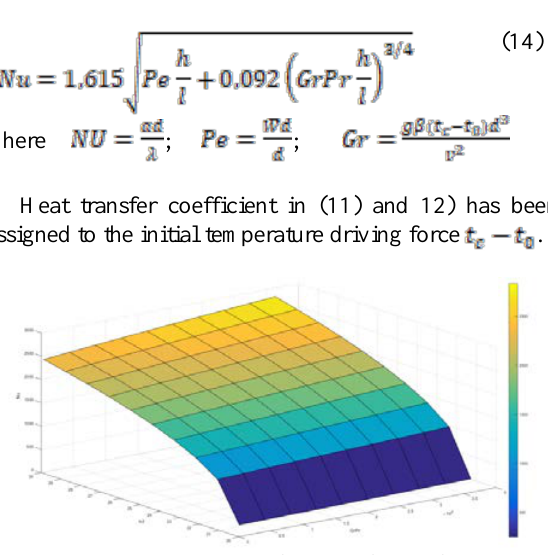
Figure 1. Nusselt criterion for liquid flow in flat tube